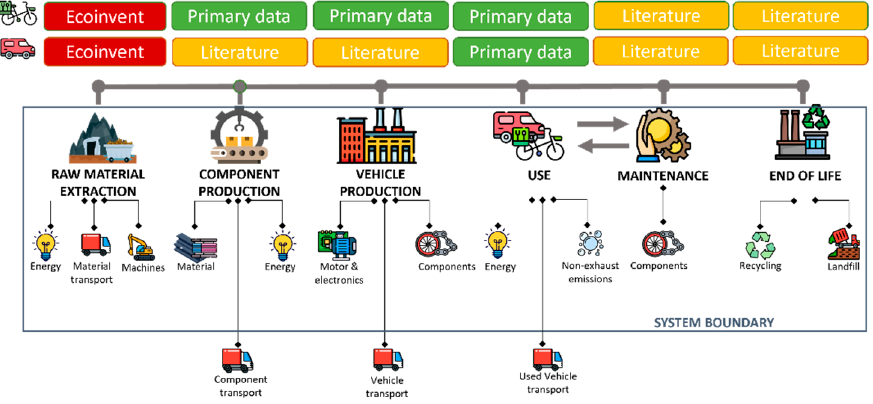
Figure 1. System boundaries and main data sources for the assessed vehicles.